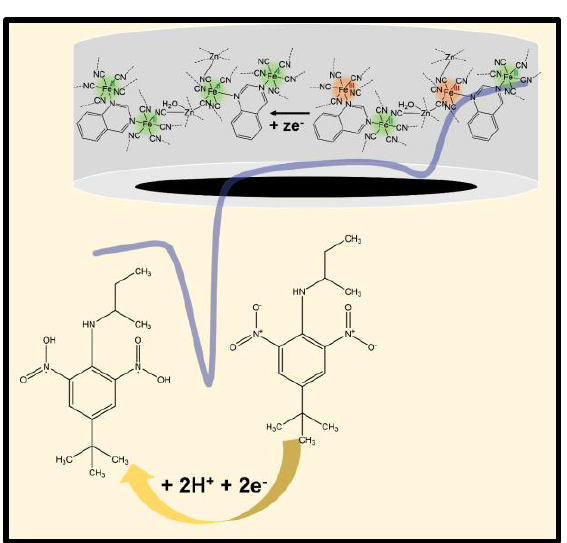
Figure 5. Proposed mechanism of BTL reduction on the surface of the PBA-qnz/CPE ratiometric sensor. The calibration plot was built under optimized conditions at the PBA-qnz/CPE sensor after successive additions of the BTL standard solution (Figure 4E). The reduction peak of BTL can be observed at − 0.57 ± 0.01 V vs. Ag/AgCl, with the current increasing propor- tionally to the species concentration, while the peak intensities referring to the reduction of the PBA-qnz remained stable at +0.15 V. The calibration plot was obtained in the range of 0.5 to 30.0 µ mol L − 1 (r = 0.998) (Figure 4F), and the equation for this plot can be expressed as I SW − BTL / I SW − PBA-qnz = 0.05 ( ± 2.0 × 10 − 3 ) [BTL]/ µ mol L − 1 + 0.03 ( ± 2.6 × 10 − 3 ). The limits of detection and quantification (LOD and LOQ) were calculated according to LOD = 3 × Sb/B and LOQ = 10 × Sb/B, where Sb is the standard deviation of intercept and B is the slope